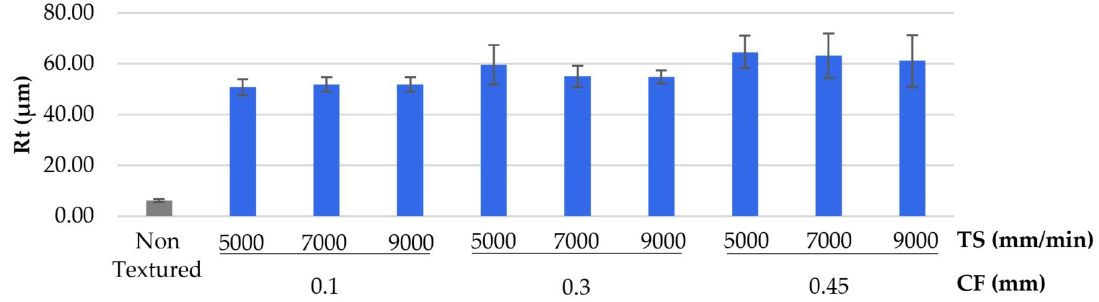
Figure 7. Rt values obtained in abrasive water jet textured tests. Table 5. ANOVA analysis of the surface quality obtained in abrasive water jet texturing.